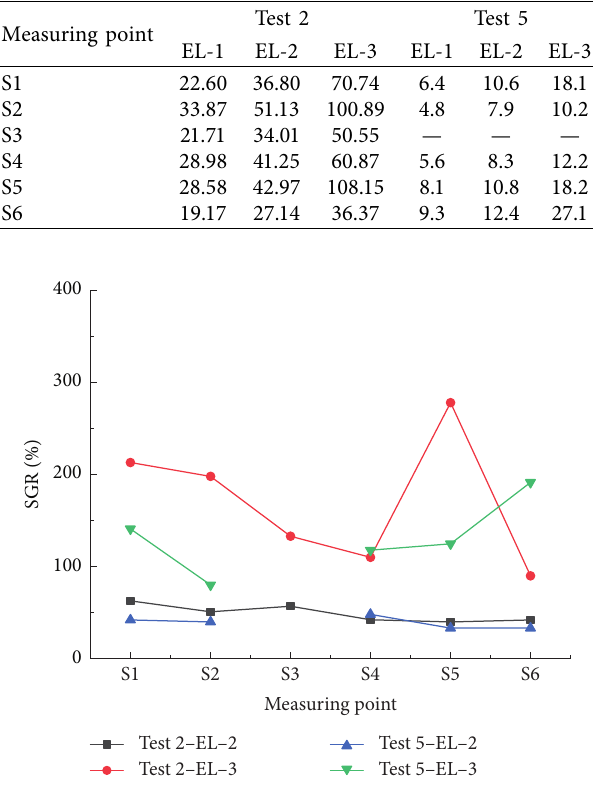
Figure 18: Case 4 strain growth rate of